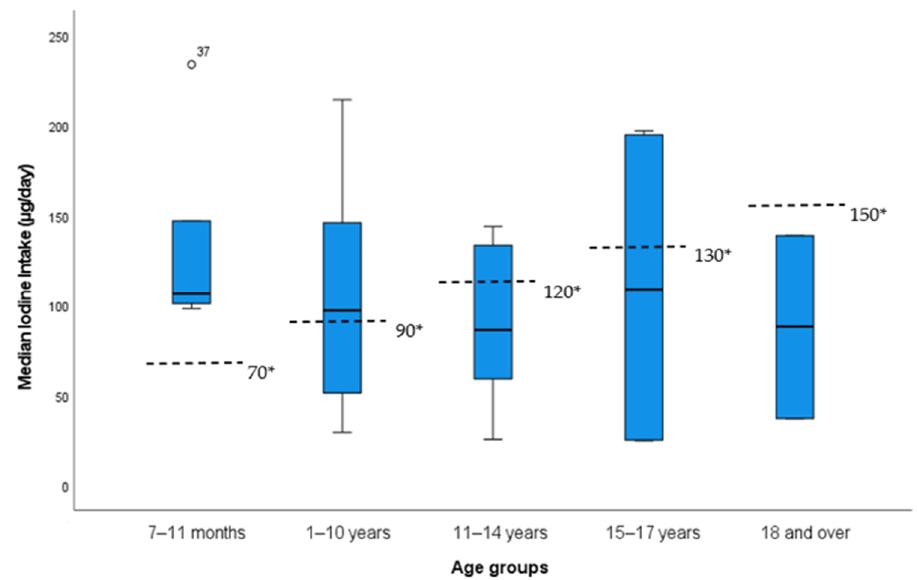
Figure 1. Distribution of estimated iodine intake across EFSA AI age groups. * EFSA adequate intake value for age [11].